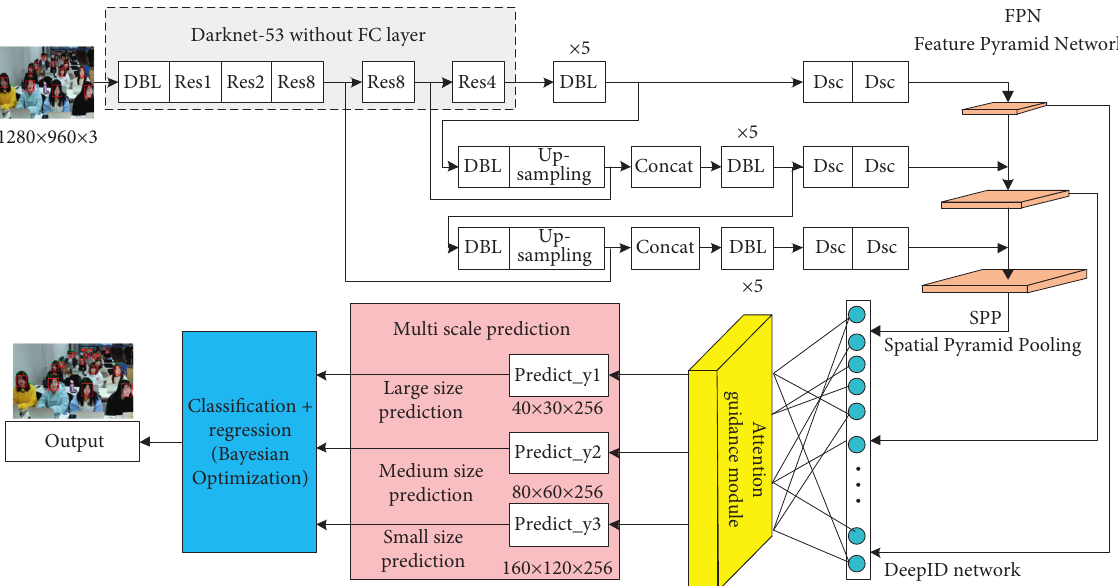
Figure 2: Improved YOLOv3 network structure.